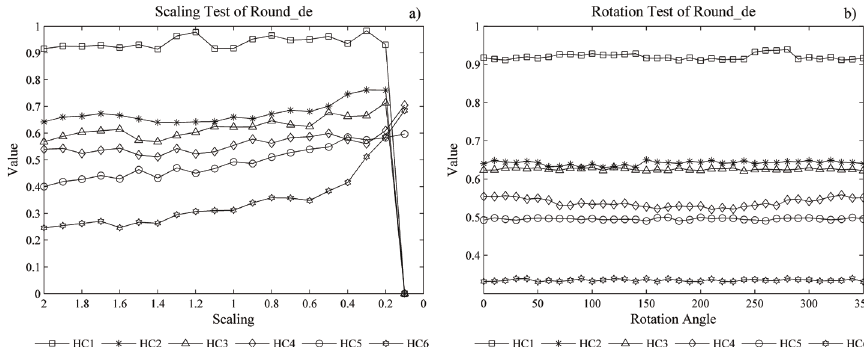
Figure 7. Tests of Round_de with Various Hydrophobic Levels. a) Scale Transformation; b) Rotation